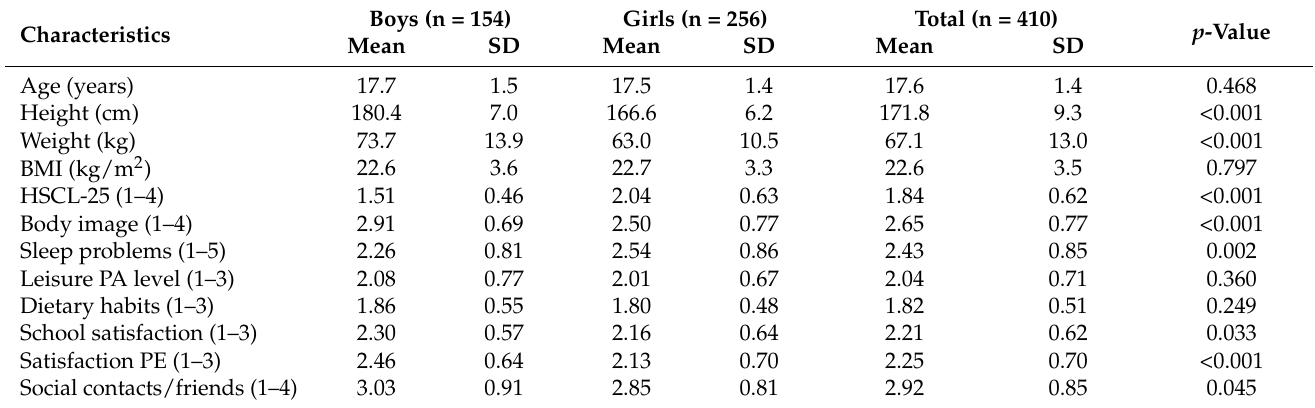
Table 1. Descriptive statistics by gender for age, anthropometric data, average score on the dependent variable ‘symptoms of mental health problems’ (HSCL-25) (measured on a ratio scale), as well as average score for the predictor variables measured at either ratio or ordinal level. The p -values refer to the gender